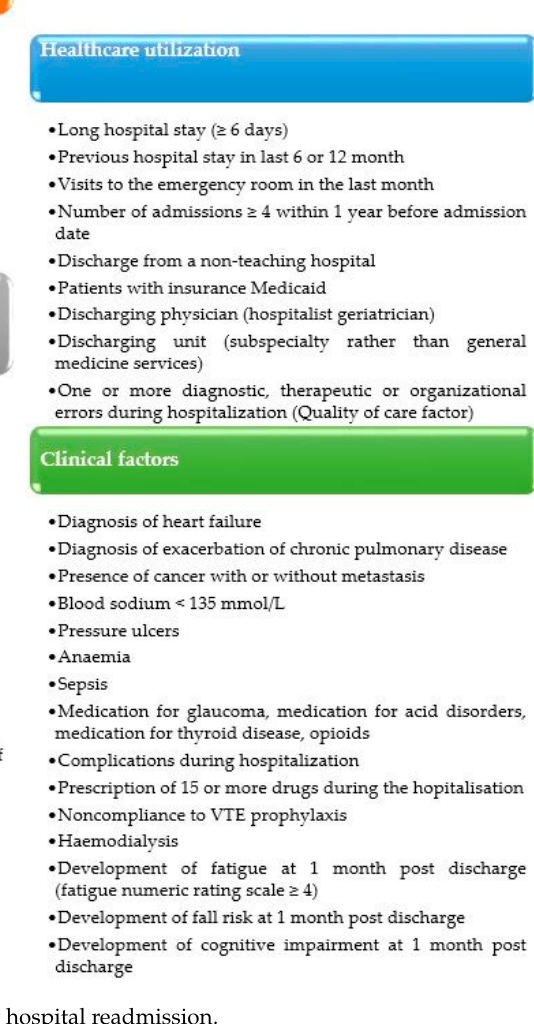
Figure 2. Risk factors for early hospital